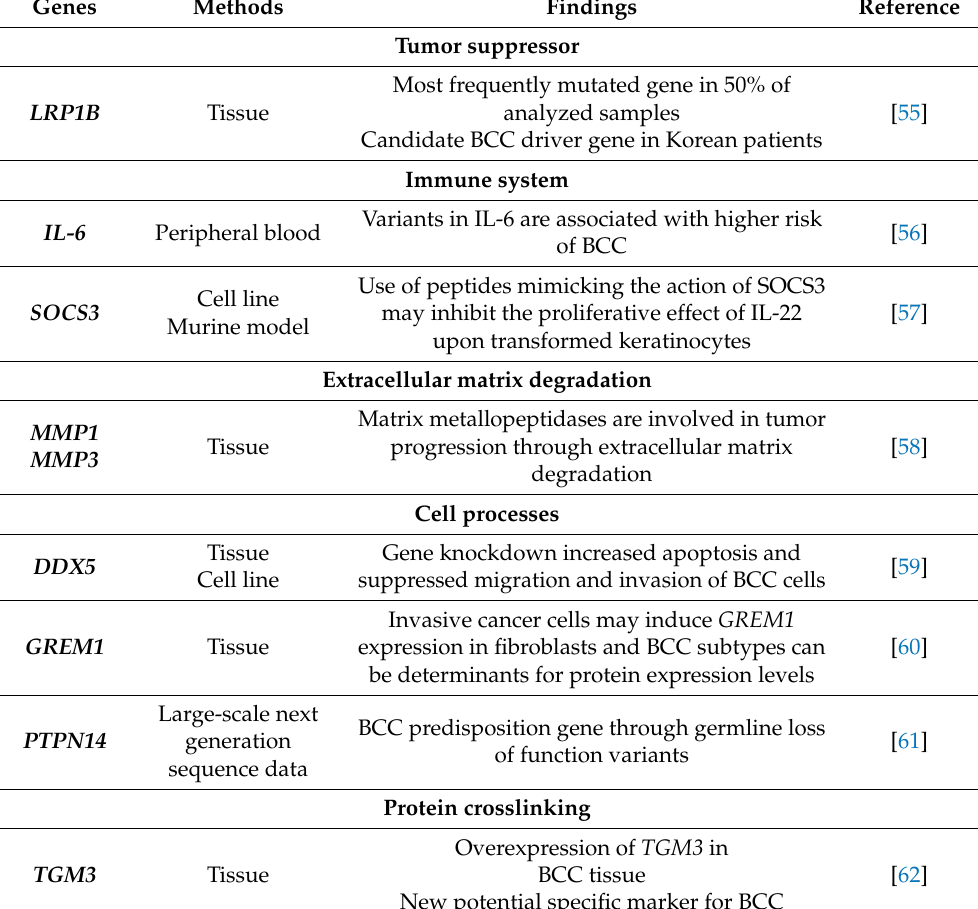
Table 1. Candidate genes for